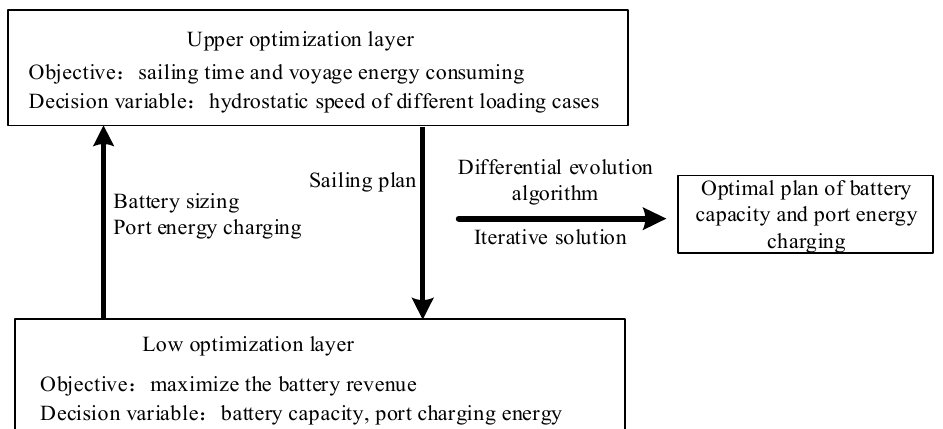
Figure 3. Bi-level optimization model of battery capacity determination for a battery-only powered ship.